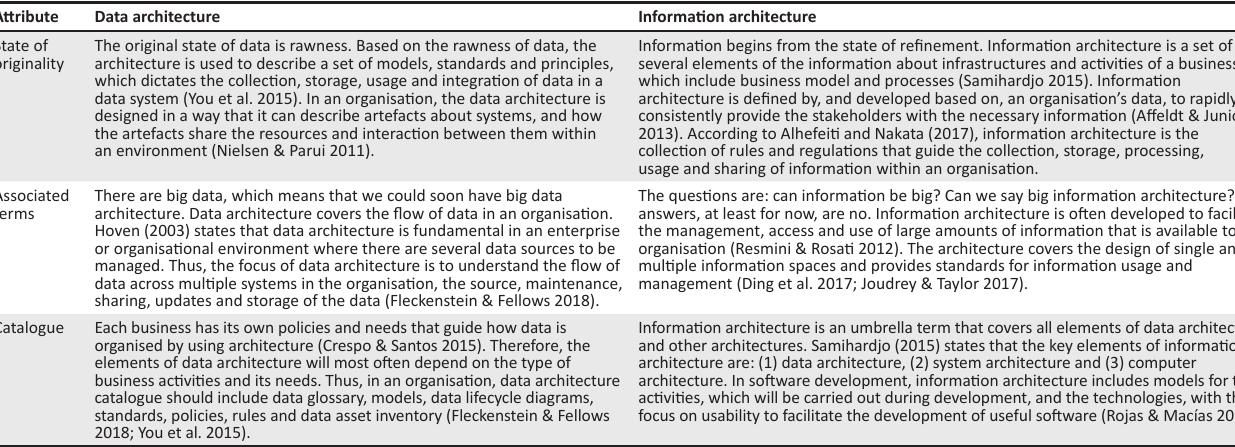
Table 2, help to differentiate between the concepts of data and information architecture.